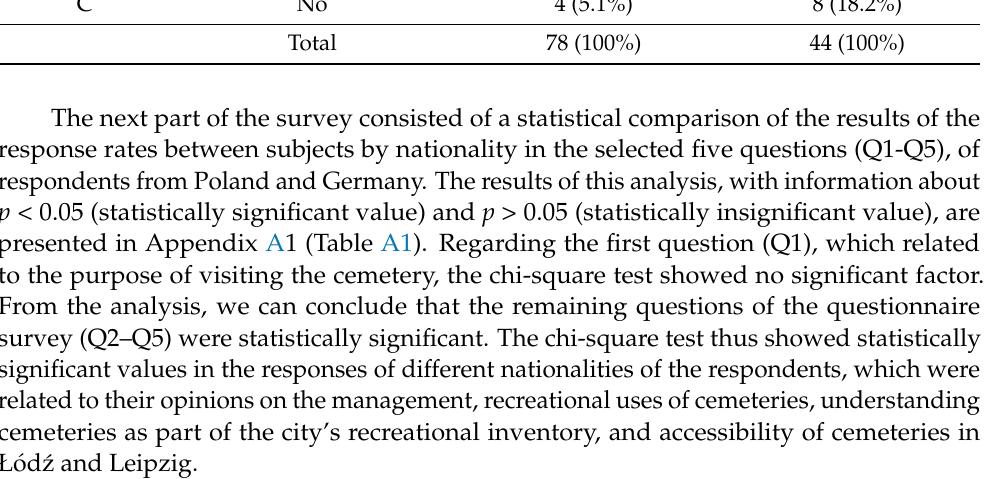
Table 6. Respondents’ opinion on accessibility of the studied cemeteries in Ł ó d´z and Leipzig. Q5. Are the Cemeteries Accessible to You? Poles Germans A Yes 68 (87.2%) 22 (50%) B Not sure 6 (7.7%) No Total 78 (100%) 44